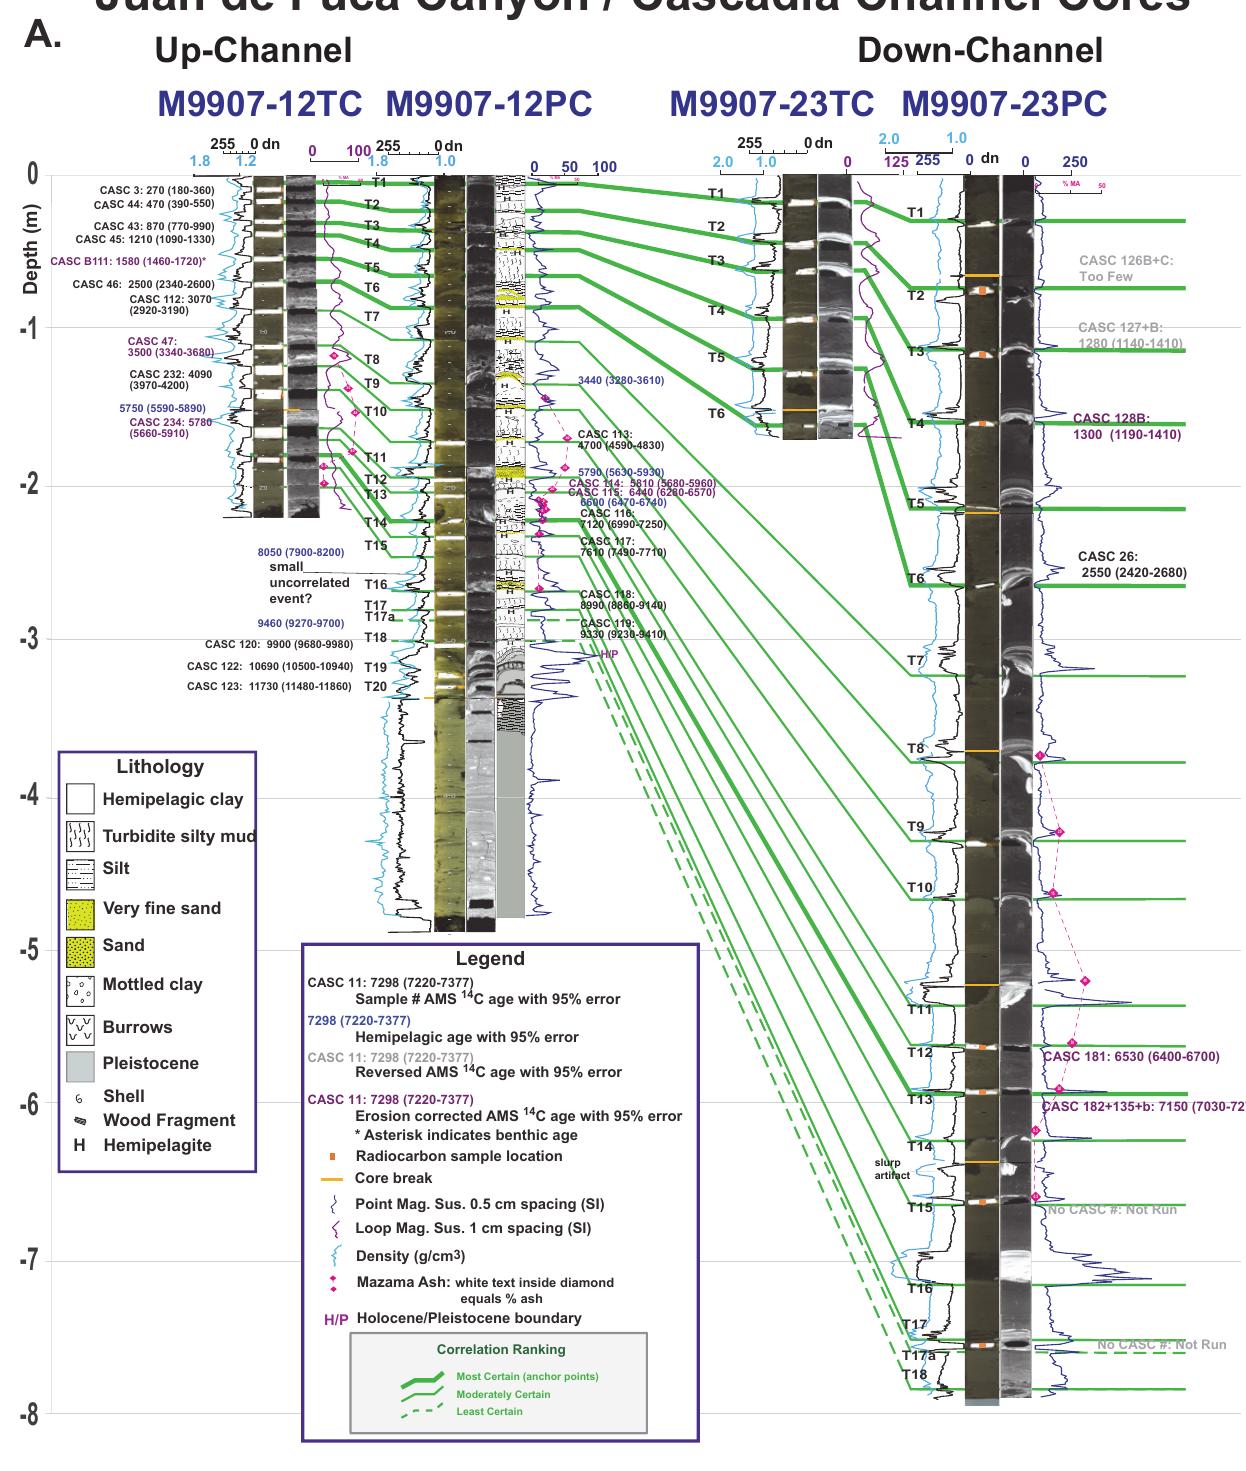
Fig. 9. Cascadia trench: Juan de Fuca (JDF) channel (a tributary to Cascadia channel) and Cascadia channel cores MM9907-12PC and M9907-23PC/TC (Fig. 4; Goldfinger et al., 2012). (A) Correlation diagram for cores 12PC and 23PC with core data plotted with same configuration as Fig. 7.